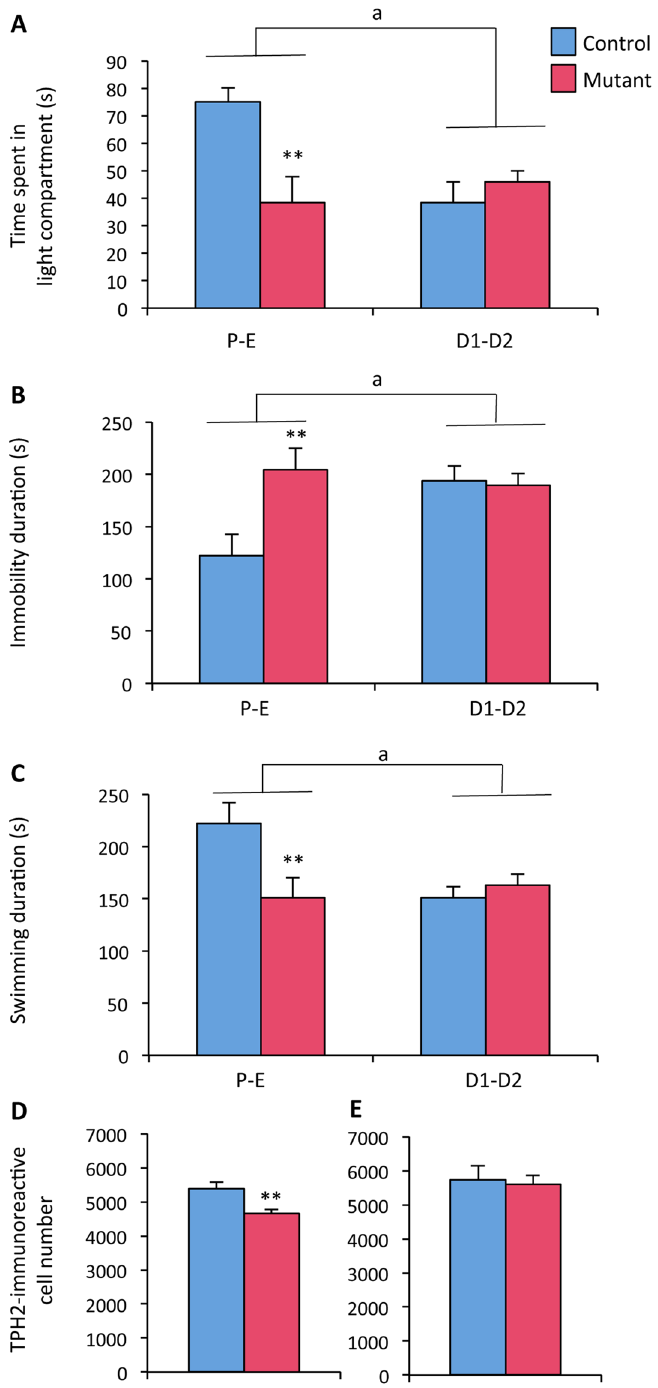
Figure 6. Anxiety- and despair-like behaviors in females, and TPH2 immunoreactivity in males and females. ( A ) Time spent in the light compartment of the dark-light box by control and mutant females at the proestrous/ estrous (PE-E) or diestrous (D1-D2) stage (n = 18–29 females per genotype). Two-way ANOVA shows an effect of cycle ( a p < 0.01); posthoc analyses indicate a reduced time spent in the light compartment for mutant females at the P-E stage (p < 0.01 versus controls at the same stage). ( B ) Time spent in immobility in the forced swim test for females at the P-E or D1-D2) stage. Two-way ANOVA shows an effect of cycle ( a p < 0.05); posthoc an a lyses indicate an increased time spent in immobility for mutant females at the P-E stage (p < 0.01 versus controls at the same stage). ( C ) Time spent swimming in the forced swim test for females at the P-E or D1-D2) stage. Two-way ANOVA shows an effect of cycle ( a p < 0.05); posthoc analyses indicate a reduced time spent in swimming for mutant females at the P-E stage (p < 0.01 versus controls at the same stage). ( D,E ) Number of TPH2 neurons counted in the dorsal raphe of females ( D ) and males ( E ). Data are means ± S.E.M. of 6–8 animals per sex and per genotype; ** p < 0.01 versus